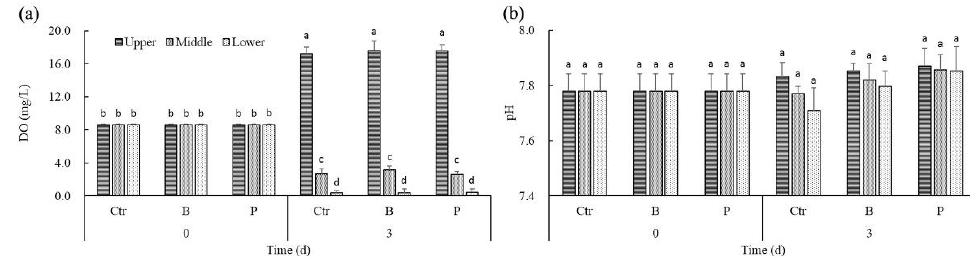
Figure 2. The effect of algicidal and denitrifying bacteria on DO ( a ) and pH ( b ) in the different layers of water.